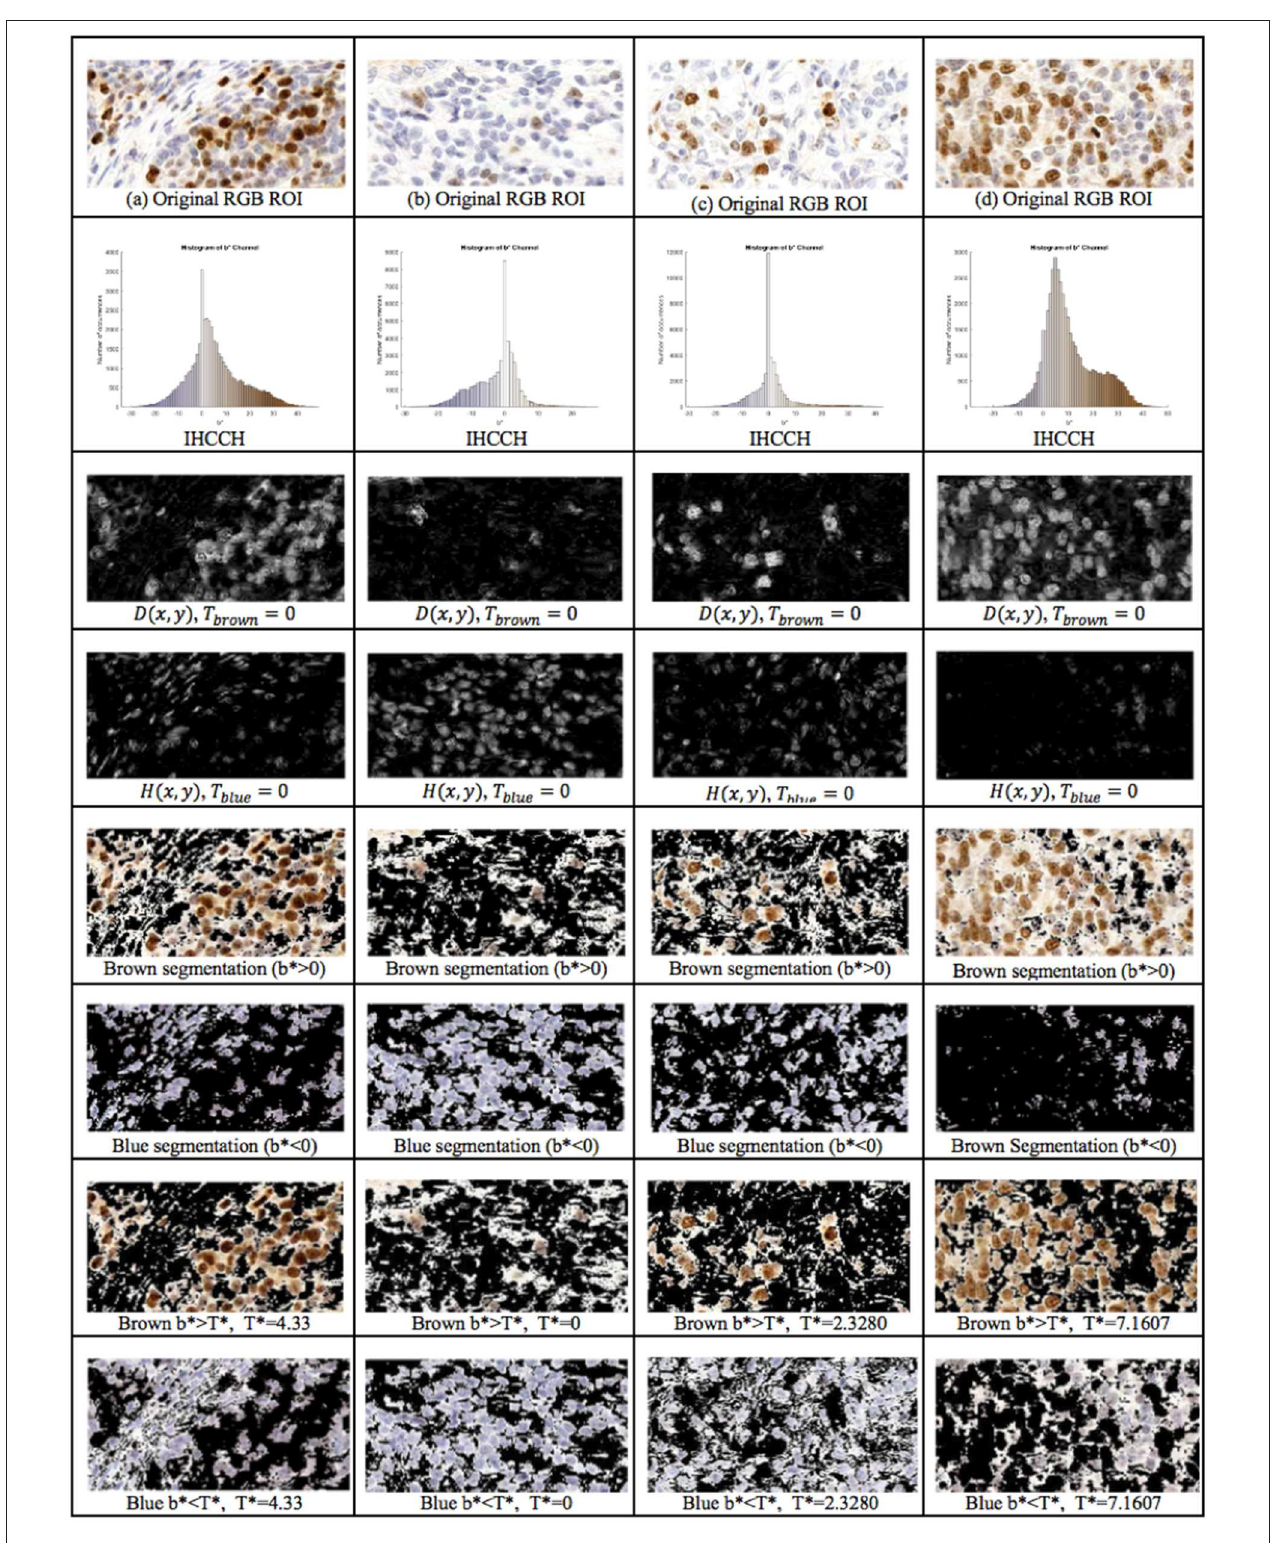
FIGURE 6 | 1st Row: Region of interest from Ki67 TMA . 2nd Row: IHCCH, 3rd and 4th row: DAB and H confidence maps for T blue = T brown = 0. 5th Row: Brown region (DAB) segmentation with T brown = 0. 6th Row: Blue region (H) segmentation with T blue = 0. 7th Row: DAB segmentation using adaptive threshold T brown = T *. 8th Row: H segmentation using adaptive threshold T blue = T